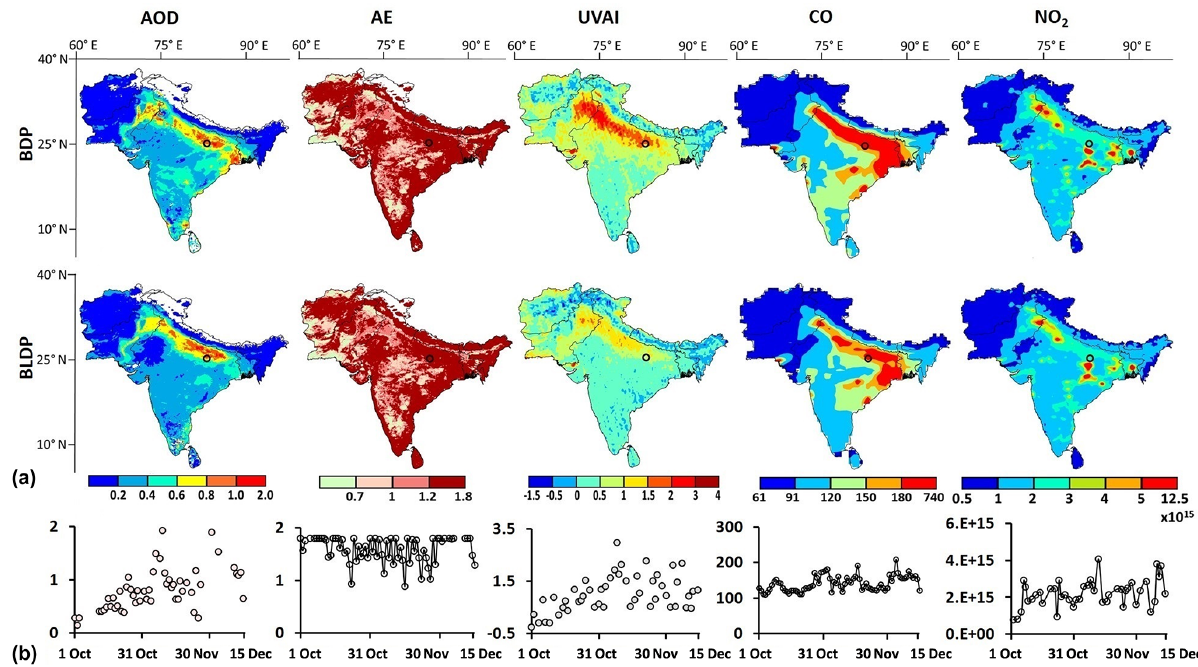
Figure 7. Episode-specific spatial distribution of AOD, AE, UVAI, surface CO (ppbv), and tropospheric NO 2 (moleculescm − 2 ) over (a) South Asia and (b) at the ground